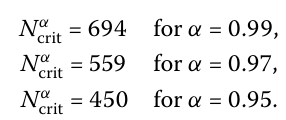
The approximate solution for α = .,.,. are displayed in Figure , which are in good agreement with the analytical